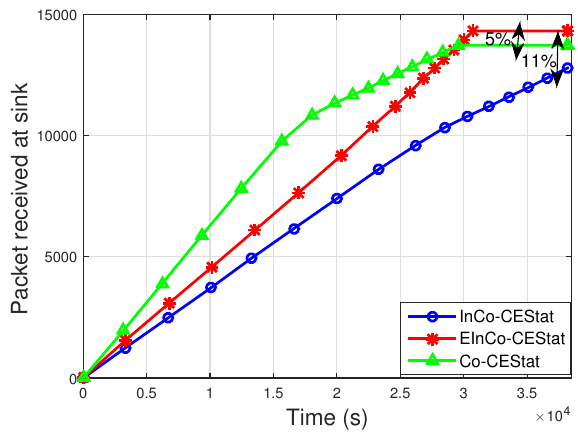
Figure 7. Number of packets received successfully at the sink.